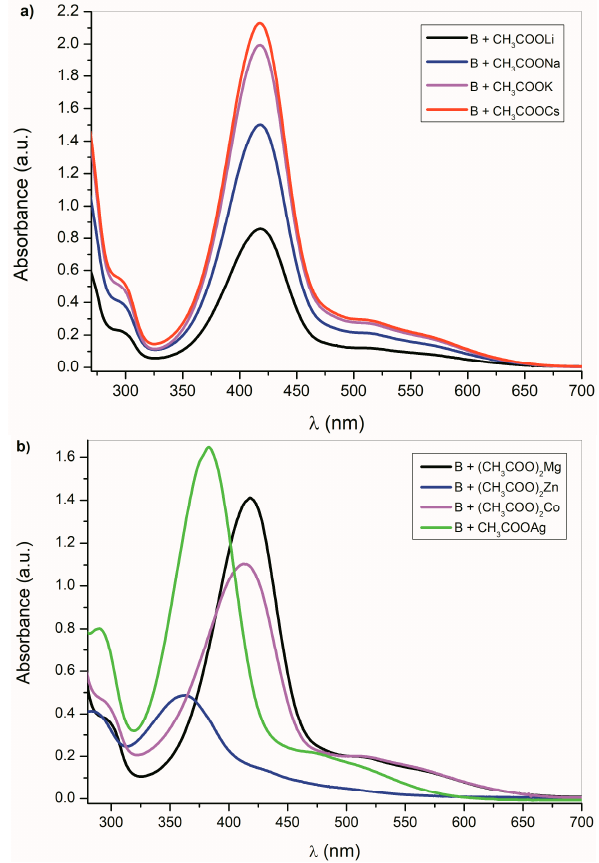
Figure 3. B UV–Vis spectra change (1 × 10 − 4 mol·dm − 3 ) in the presence of ( a ) alkali metal acetates ( b ) other metal acetates in